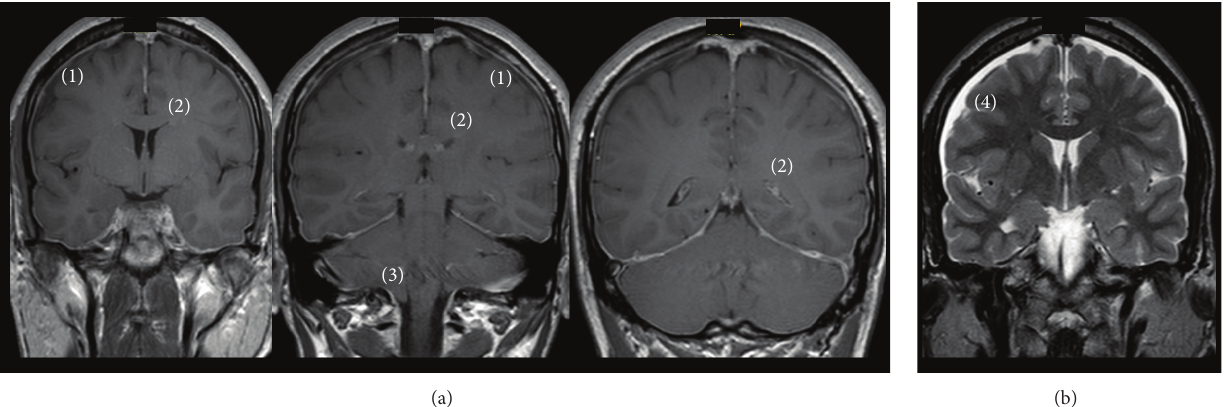
Figure 1: (a) T1-weighted brain MRI scan with gadolinium showing diffuse pachymeningeal enhancement (1), decrease in ventricle size (2), and cerebellar tonsil descent (3). (b) T2-weighted brain MRI scan showing subdural fluid collections (4).